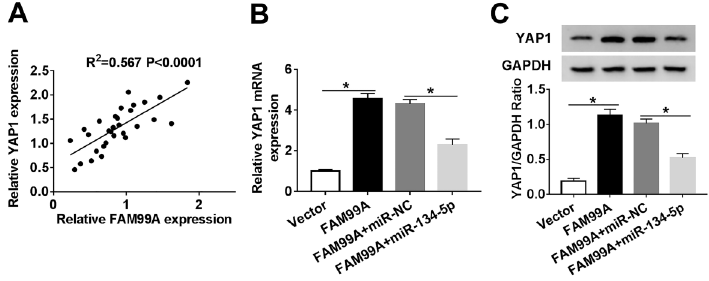
Figure 7. A , The correlation between YAP1 and FAM99A is shown. B and C , HTR8/SVneo cells were transfected with Vector, FAM99A, FAM99A + miR-NC (negative control), or FAM99A + miR-134-5p. B , The mRNA level of YAP1 was examined by qRT-PCR. C , The protein level of YAP1 was measured via western blot assay. Data are reported as means ± SD. *P o 0.05